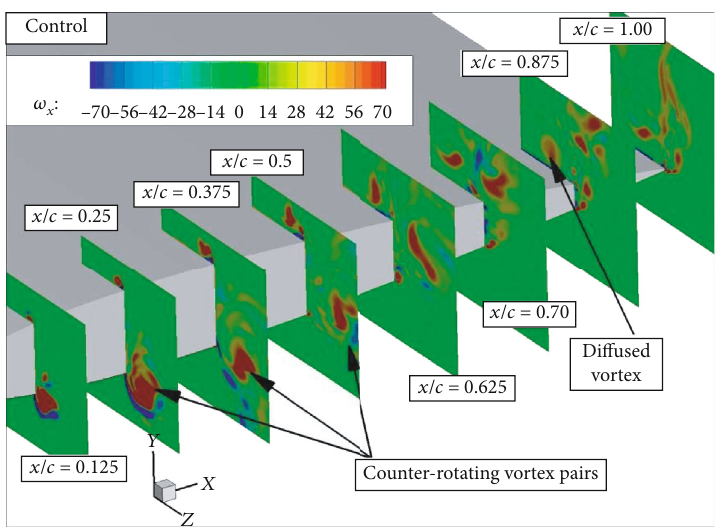
Figure 20: The axial vorticity distribution under normal blowing.